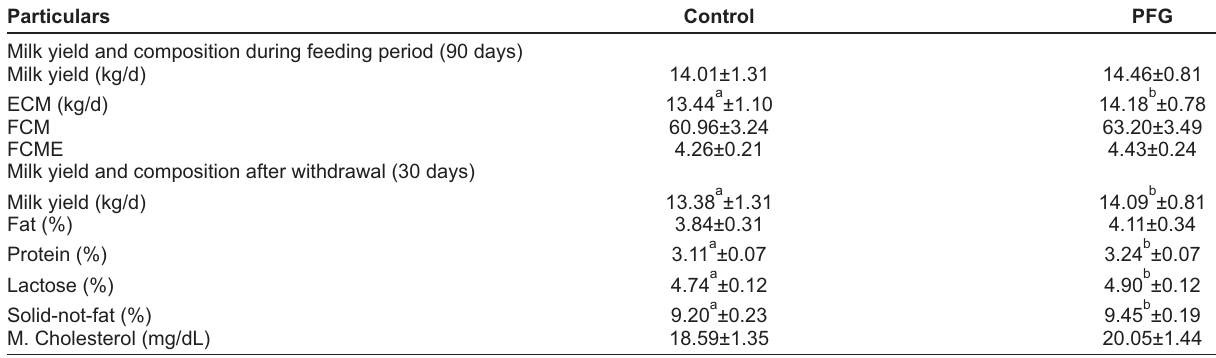
Table-3: Milk yield and composition in control and prill fat fed (PFG) cows during mid lactation Particulars